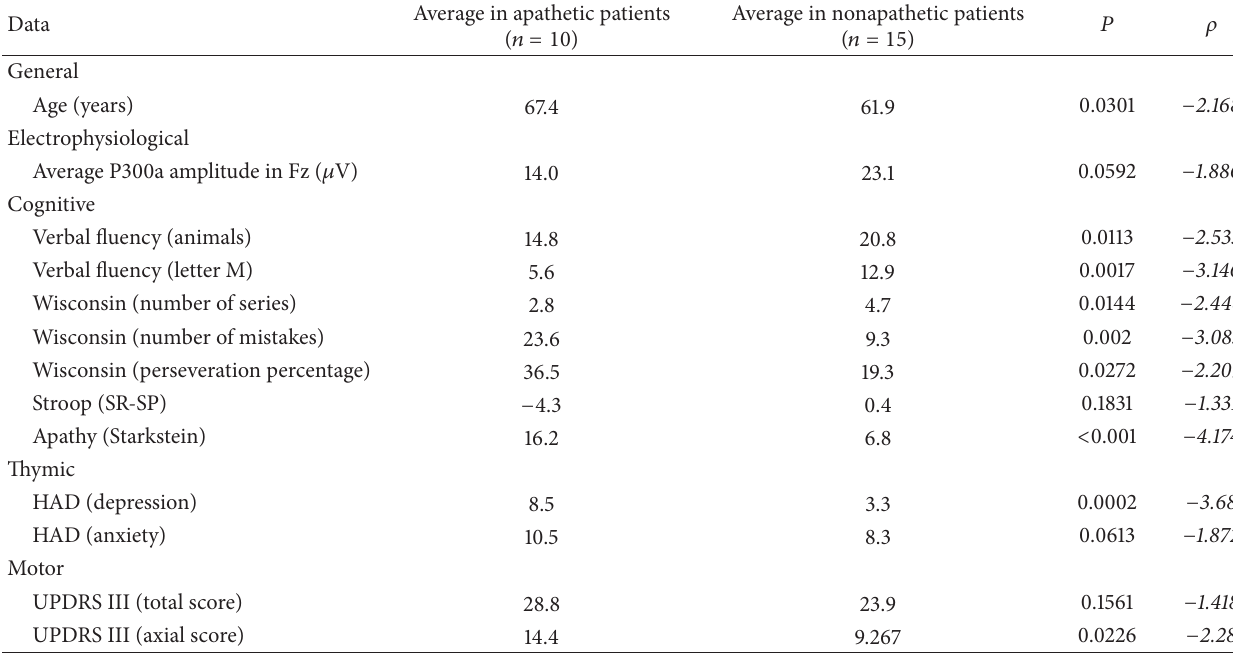
Table 2: Characteristics distinguishing apathetic from nonapathetic patients during OFF period.